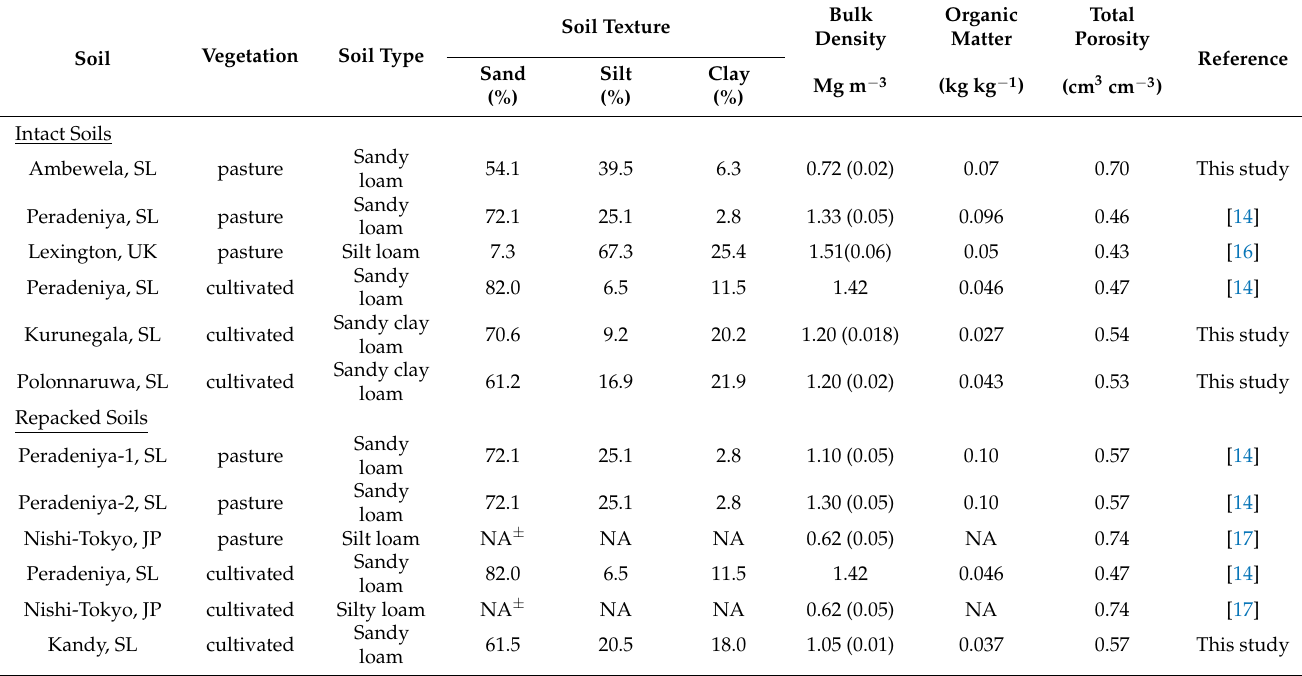
Table 1. Soils and data from the literature and their physical